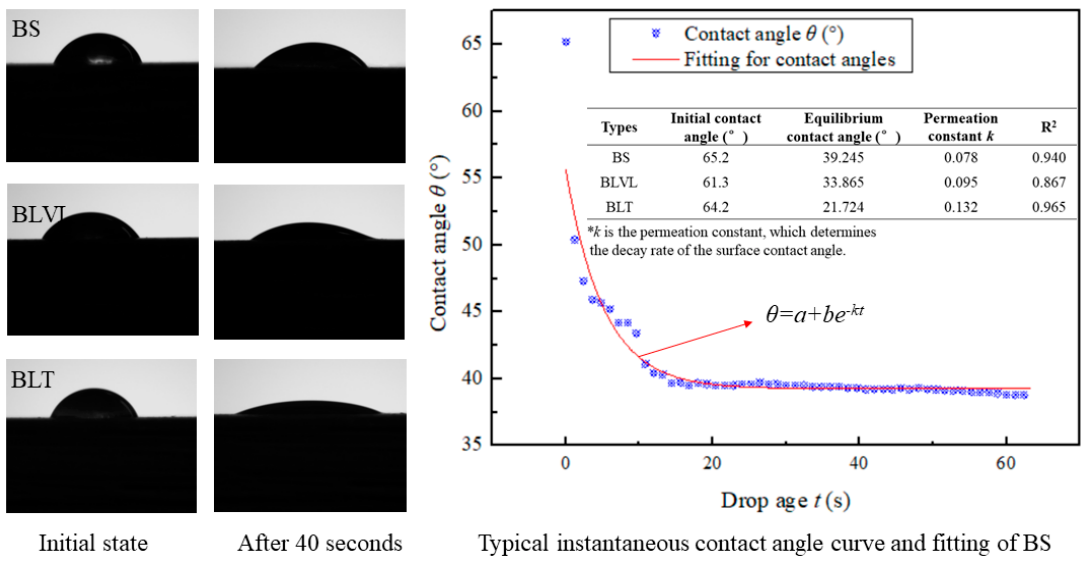
Figure 5. The apparent contact angles of water on the surfaces of the three bamboo composites.